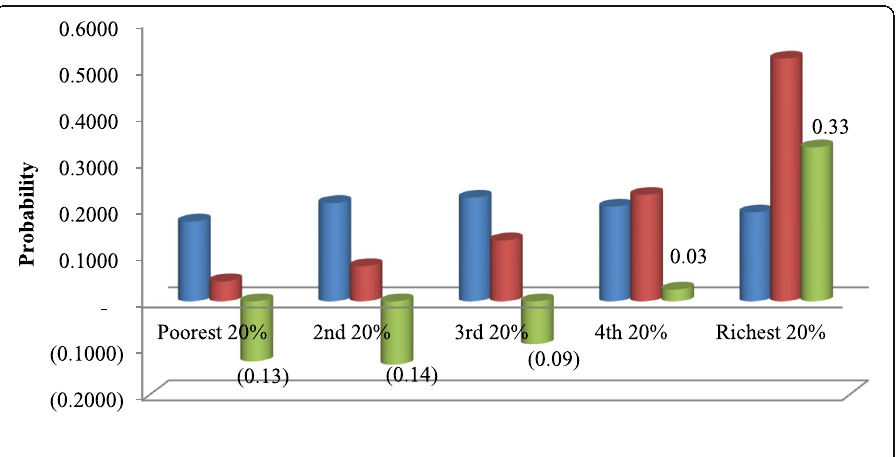
Fig. 2 Distributive benefit by income quintile when access to traditional crop insurance to individual farmers is